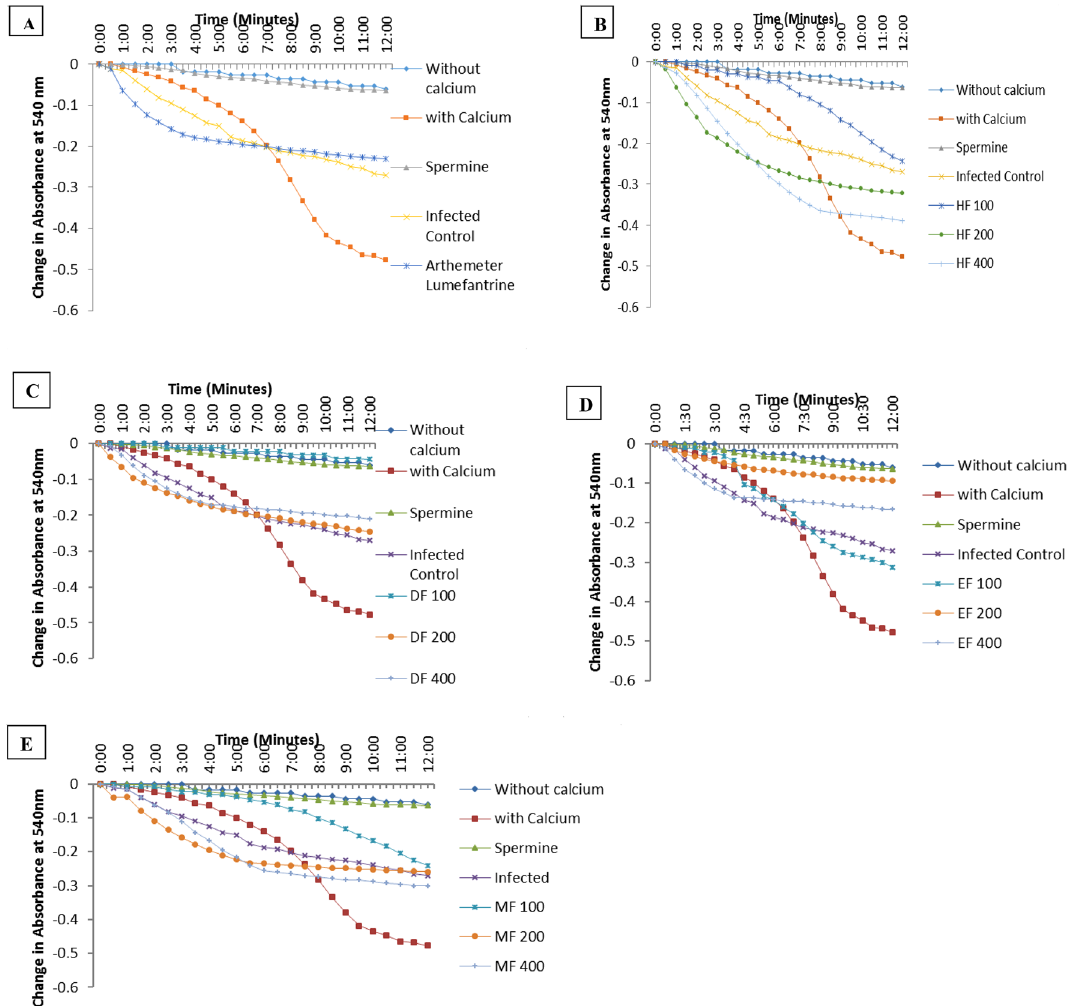
Figure 2. Representative profile of effects of Diospyros mespiliformis solvent fractions on mitochondrial permeability transition pore opening. ( A ) Isolated mitochondria integrity is shown by insiginifant decrease in changes in absorbance for 12 min at 30 s interval (without calcium), susceptibility of these mitochondria to calcium induction of the mPT pore opening was revealed by significant difference in changes in absorbance (withcalcium) and reversal by spermine was shown as insignificant decrease in changes in absorbance (spermine). ( B ) Hexane fraction (HF) of DM dose dependently opened the mPT pore maximally at 400 mg/ kg and higher than infected control. ( C ) DF reversed opening of the pore by malarial infection and similar results were obtained in the EF group ( D ). ( E ) Only 400 mg/kg dose of MF opened the pore more than malarial